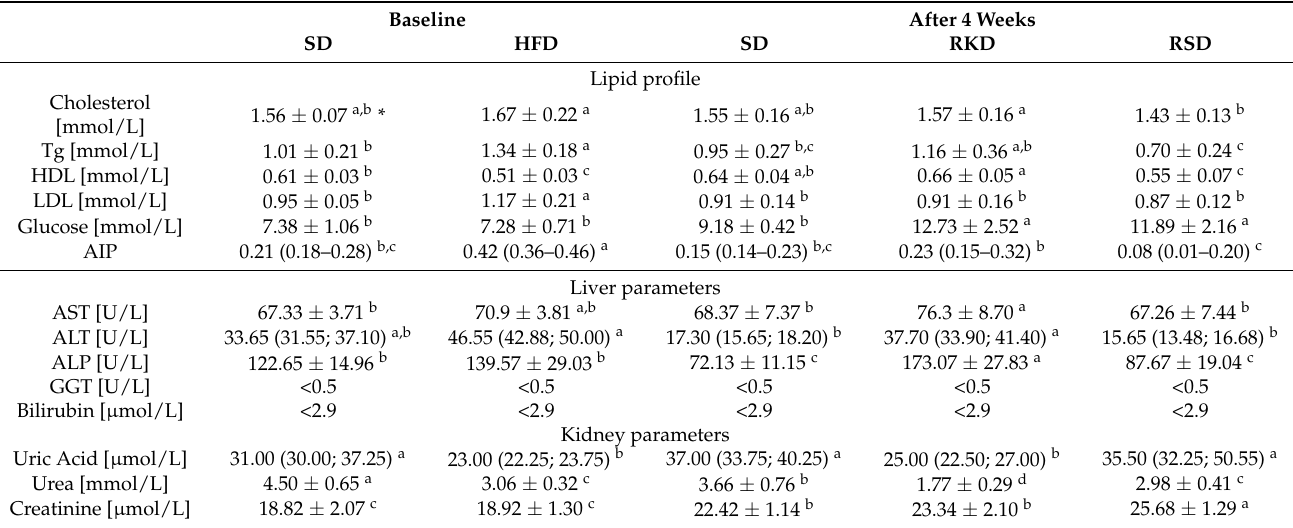
Table 2. Plasma lipid profile, liver and kidney parameters in rats before and after dietary intervention. Quantitative variables with a normal distribution are expressed as mean ± SD; quantitative variables which showed a non-normal distribution are expressed as median (Q1;